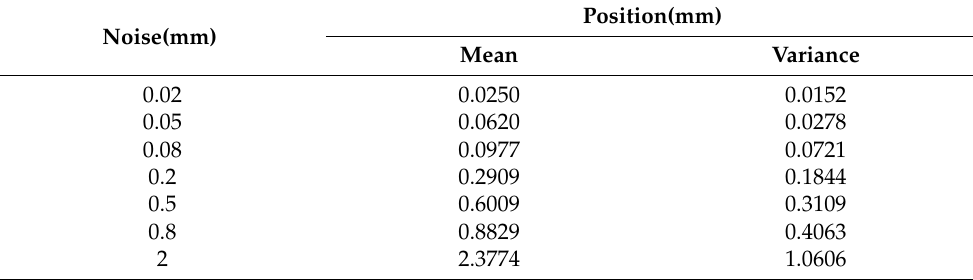
Table 3. Displacement